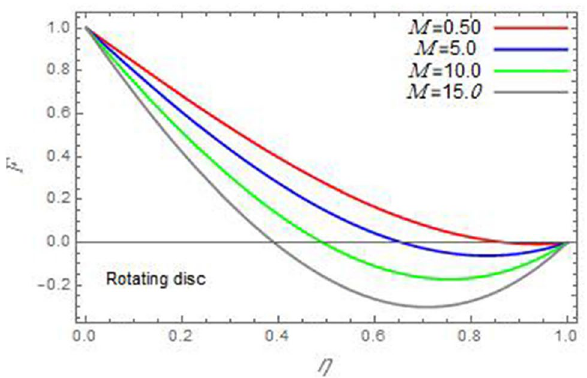
Figure 7. The radial velocity F versus the axial variable η in the case of stationary cone to depict the effect of the magnetic parameter M .